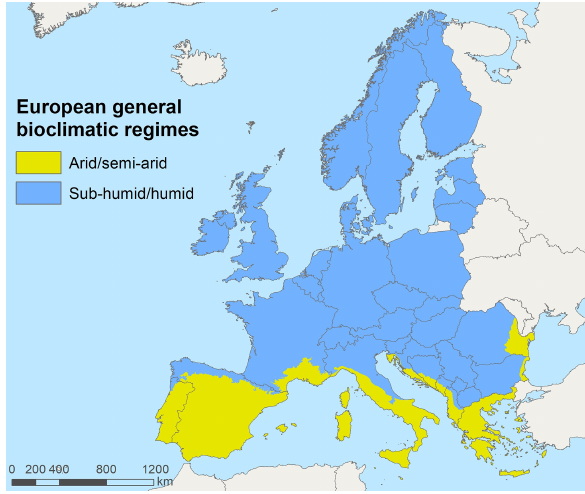
Figure B1. Location of the arid/semi-arid and sub-humid/humid regimes over Europe.